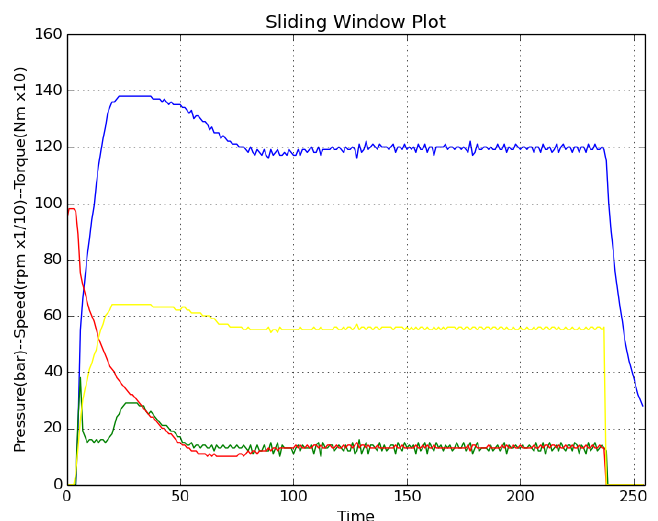
Figure 17. Pressure loop at 120 bar.